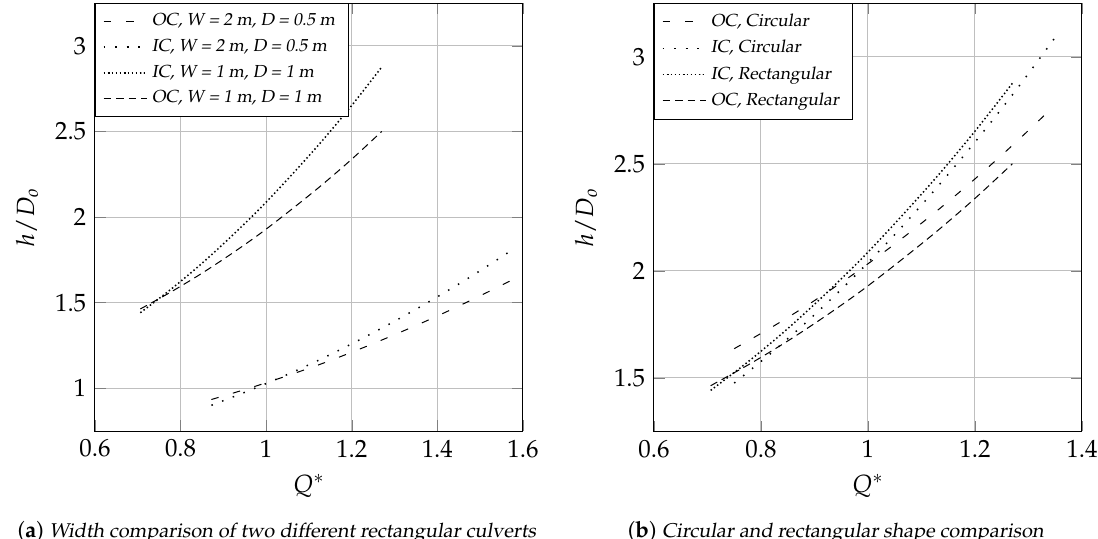
Figure 2. Comparison between different widths and